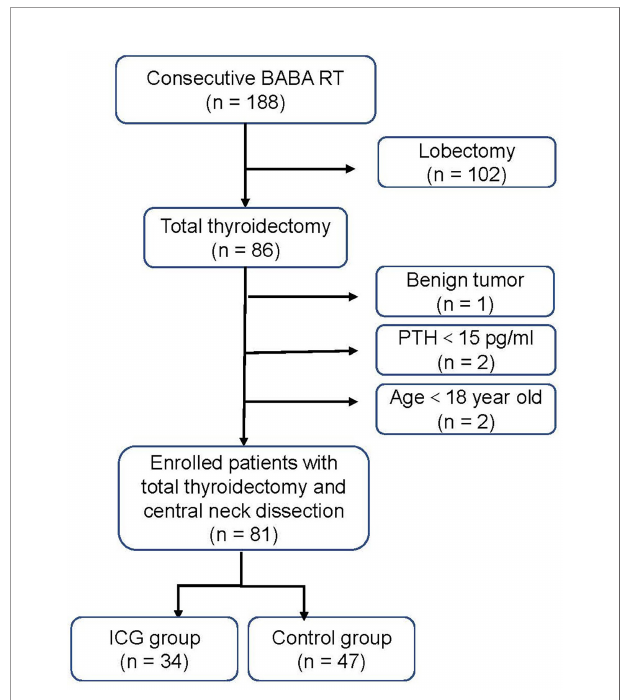
FIGURE 1 | Flow diagram of the study patients. BABA RT bilateral axillo- breast approach robotic thyroidectomy. PTH parathyroid